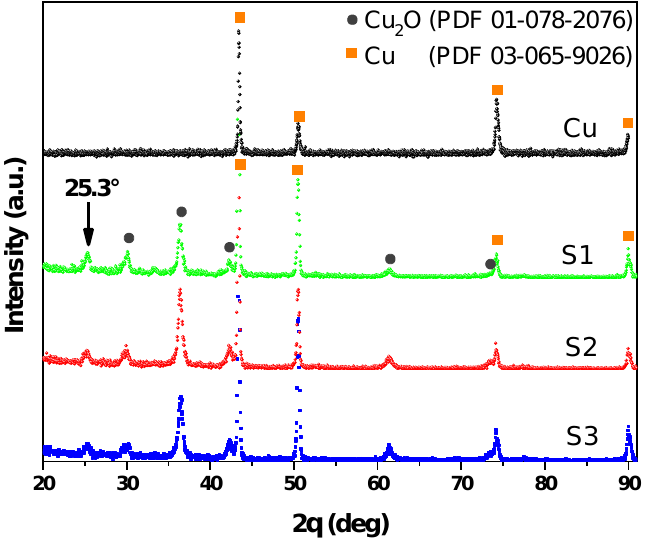
Figure 2. X-ray diffractogram of pure copper (Cu) and insulating oxidized copper (S1, S2, and S3). Figure 3 exhibits the morphology of the insulating film obtained by SEM; observe the formation of Cu 2 O crystals with different facets. The films have polyhedral architectures. The film thickness is between 1.355 and 1.442 µ m.